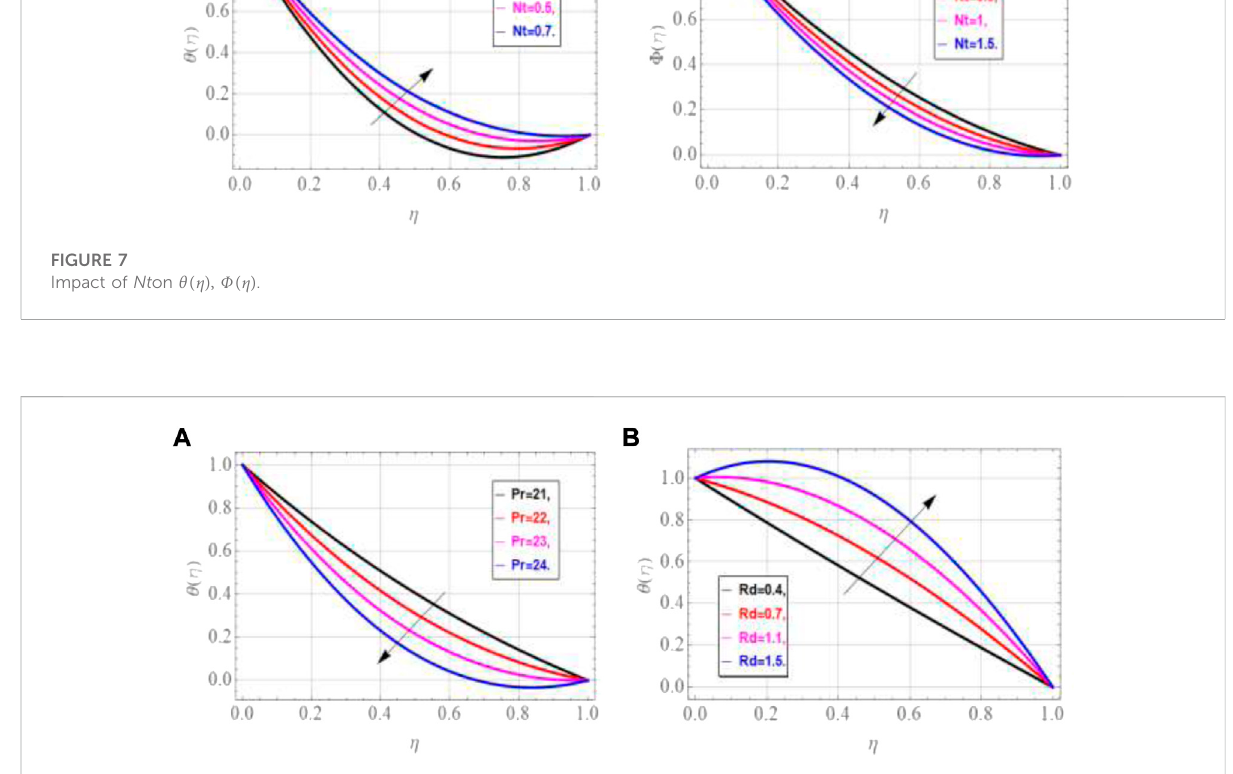
FIGURE 8 Impact of Pr and Rd on θ ( η )